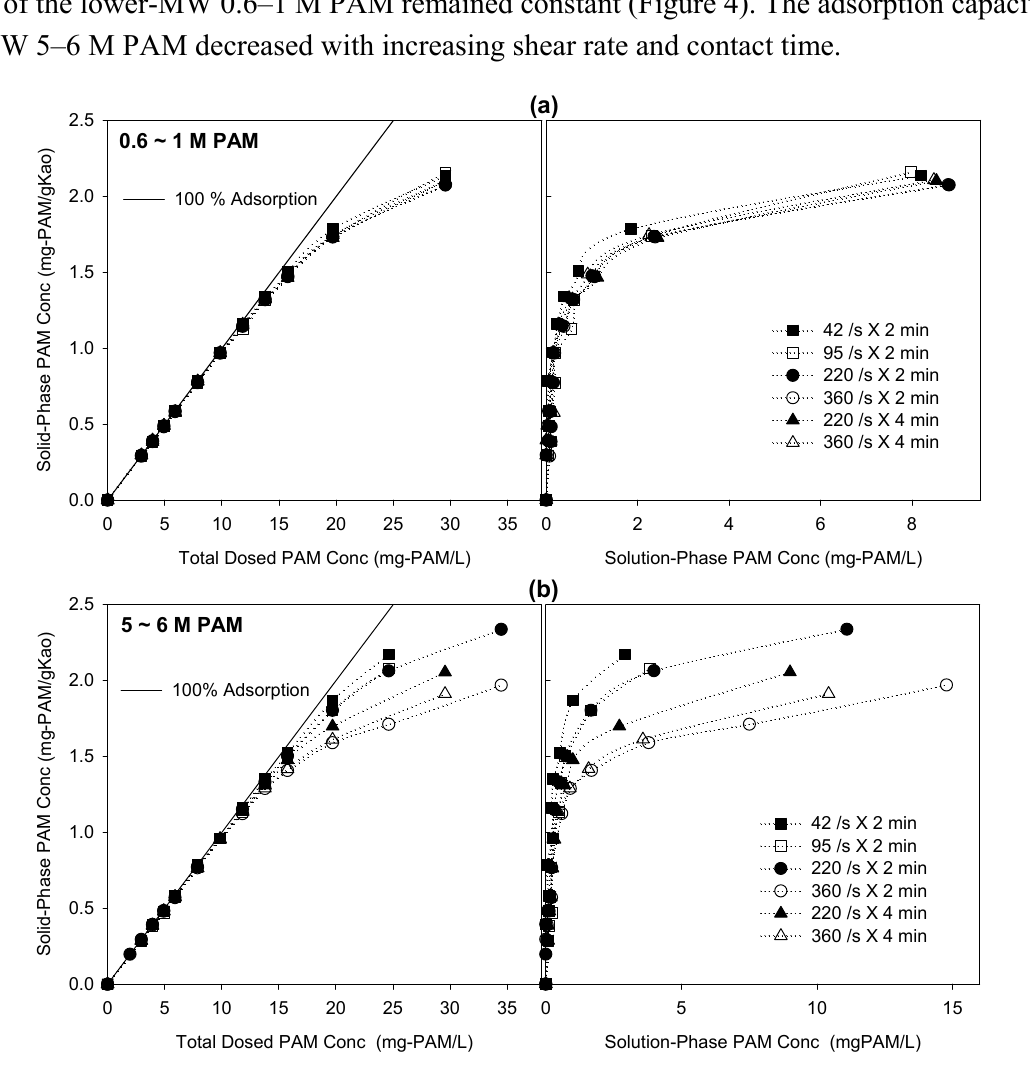
Figure 4. Experimental results of flocculation tests performed using 0.6–1 M and 5–6 M polyacrylamides (PAMs) at different shear rates and contact times. ( a , b ) represent PAM adsorption capacity versus PAM concentration for 0.6–1 M and 5–6 M, respectively. The x-axis represents the total dosed PAM concentrations in the left-hand panels, and solution-phase PAM concentrations in the right-hand